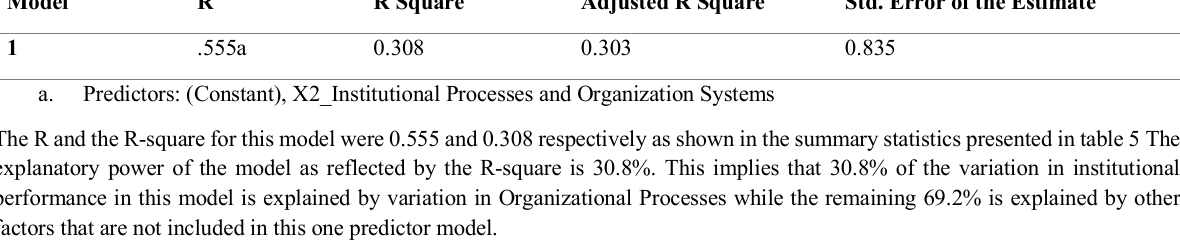
Table 6: Model coefficients; Institutional Processes and Institutional Performance